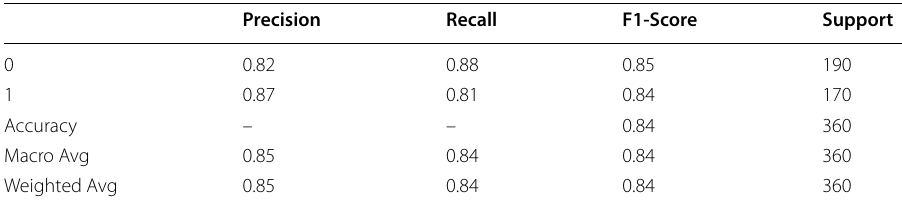
Table 11 Experiment 2 with AJGT